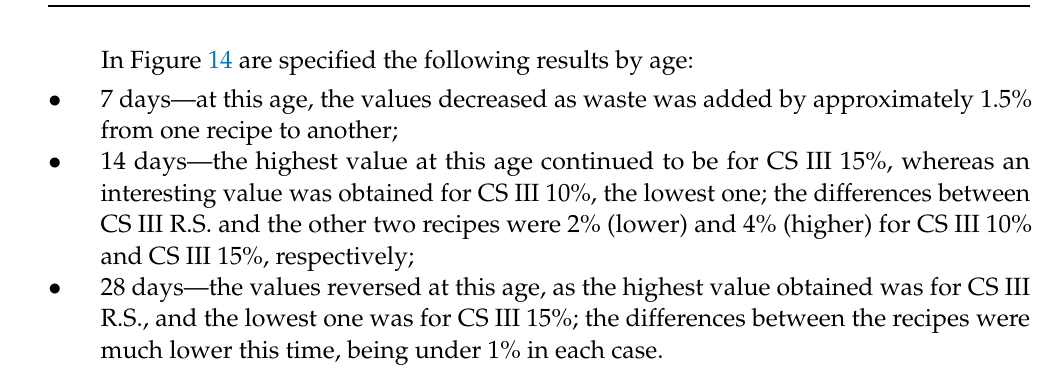
Table 7. Results for bending strength on hardened mortars .